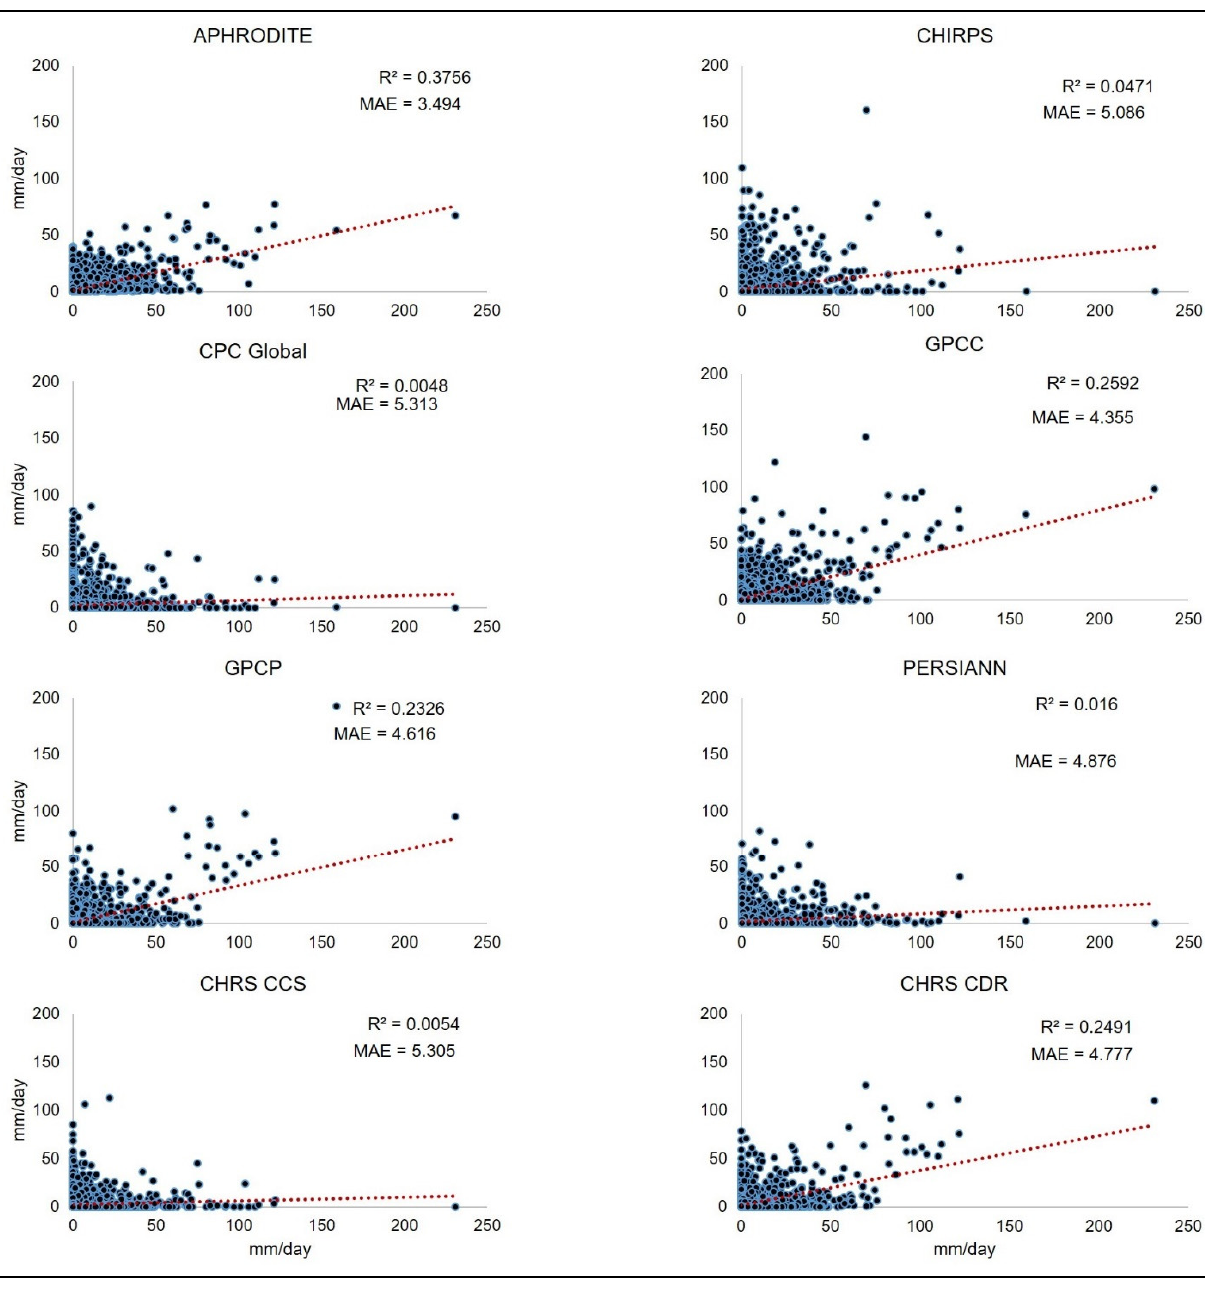
Figure 4. Performance of different PPs against gauged precipitation in simulating daily precipitation in Chirah sub-catchment.